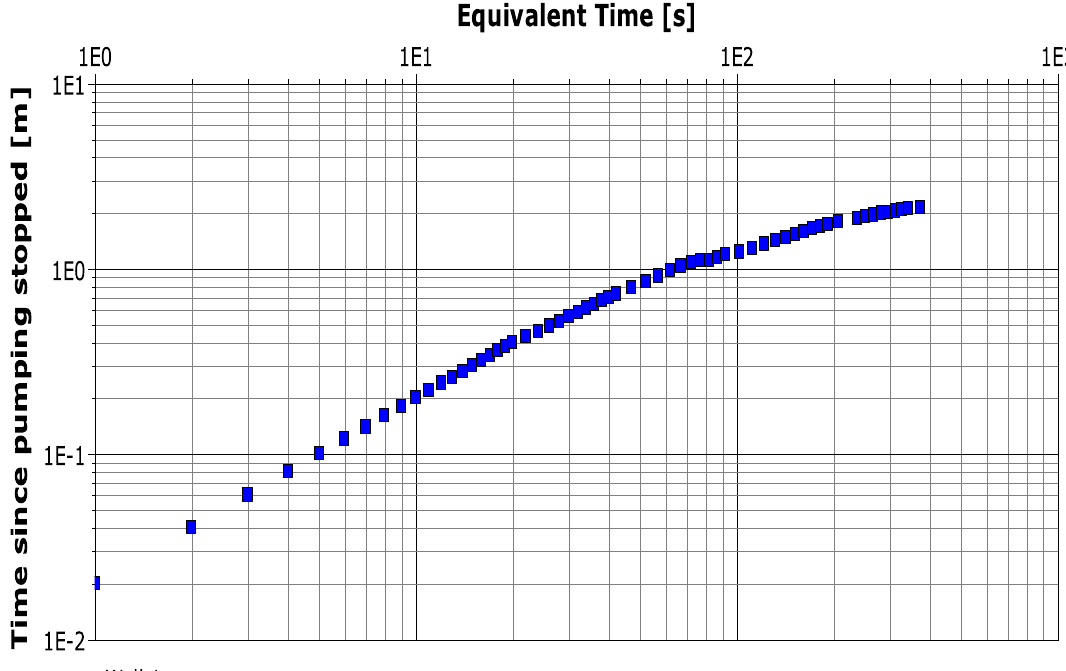
Fig. 6 Plotting of recovery rate of well-1 using aquifer mapping